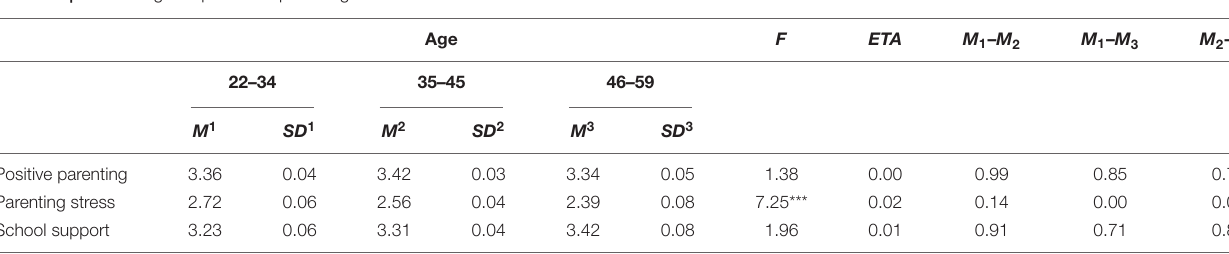
TABLE 8 | Effect of age on perceived